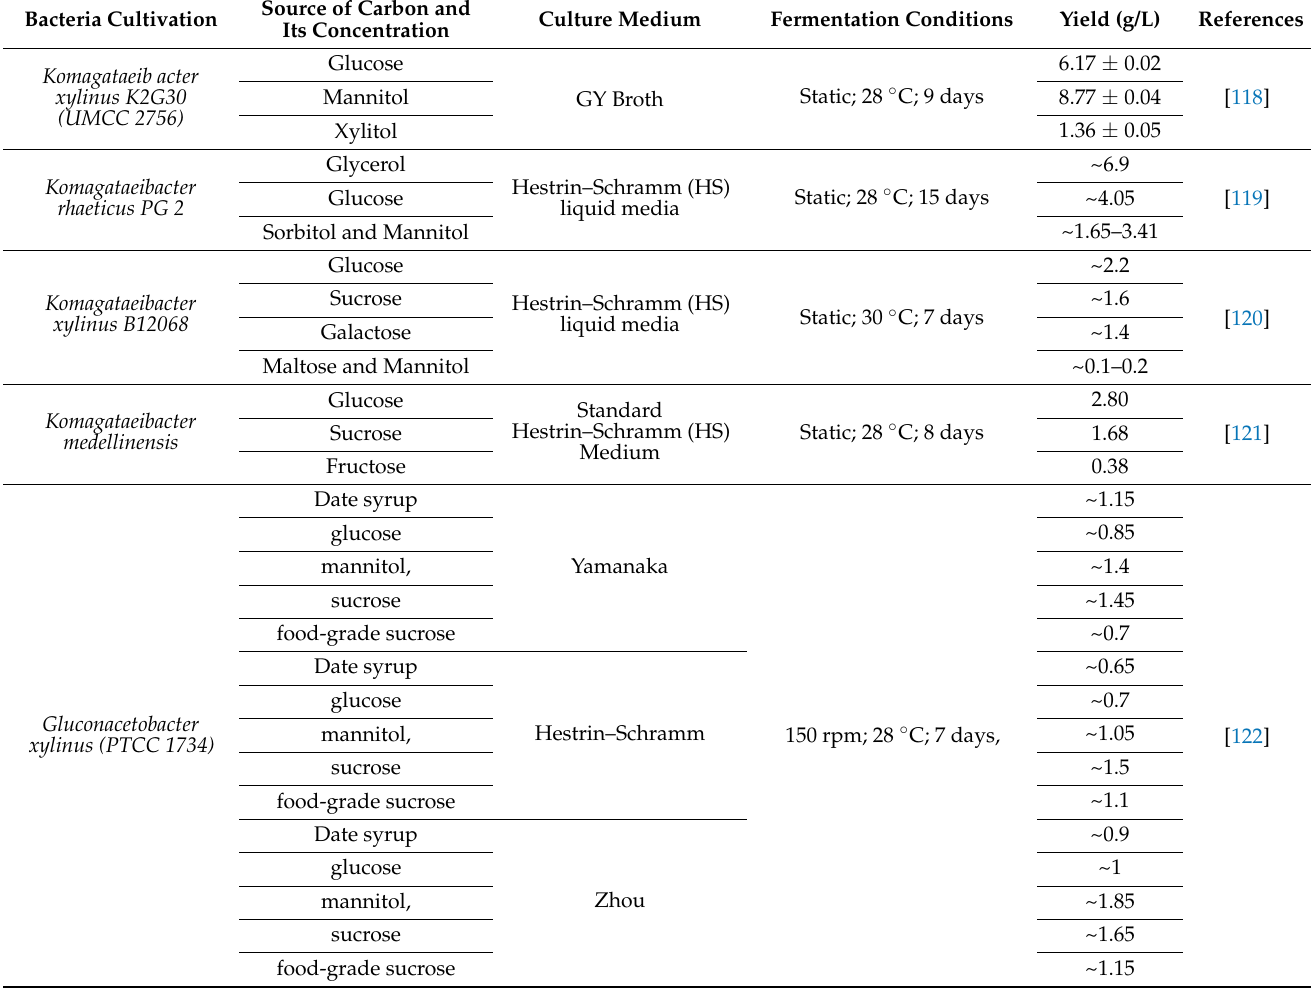
Table 3. Recent study of bacteria cellulose